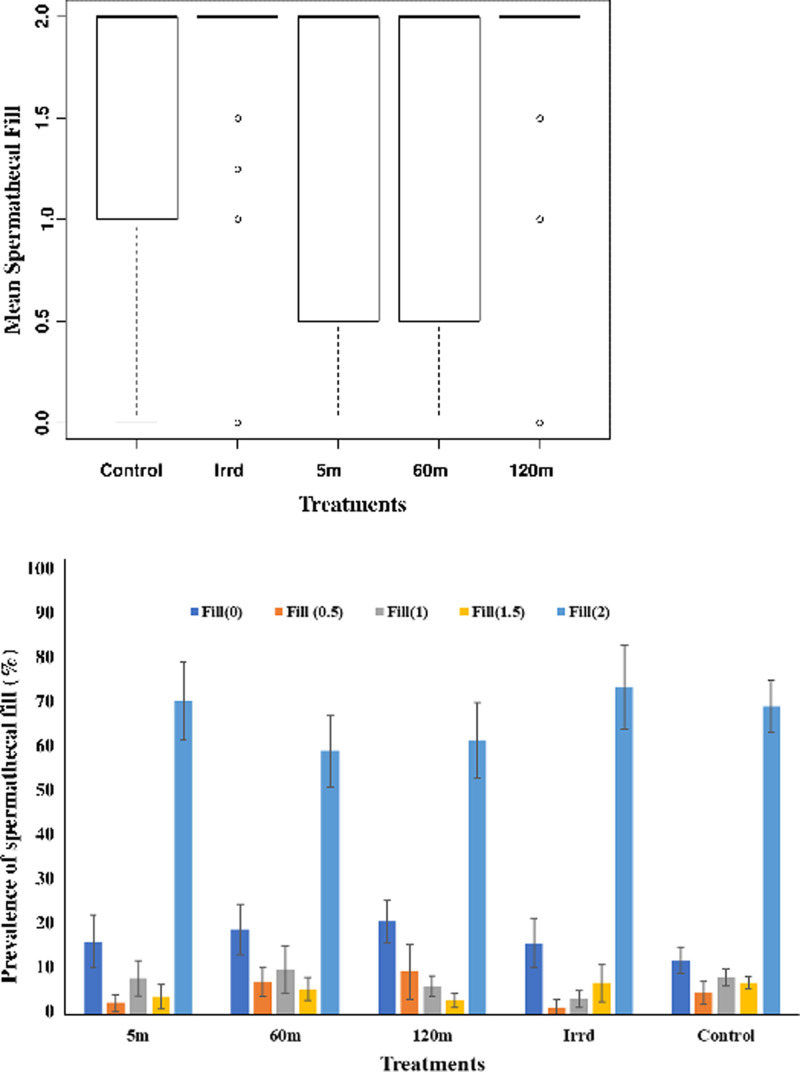
Impact of the release process through the BSITM on the insemination rate of mated females.A, Mean spermathecal fill scores; B, distribution of spermathecal fill within treatments (X2 = 14.849, df = 16, P = 0.5358). The spermathecal fill was scored by estimating the size of the sperm mass under a compound microscope to the nearest 0.5 for each spermatheca separately and then summing the two values, giving values of 0, 0.5, 1.0, 1.5 and 2.